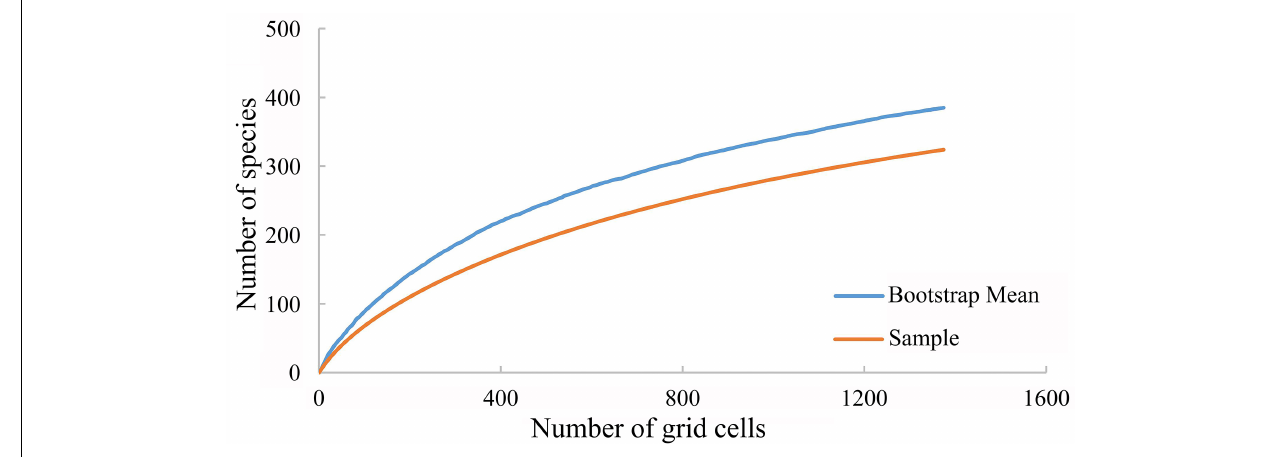
FIGURE 1 | Species accumulation curves for Lycocerus by the global